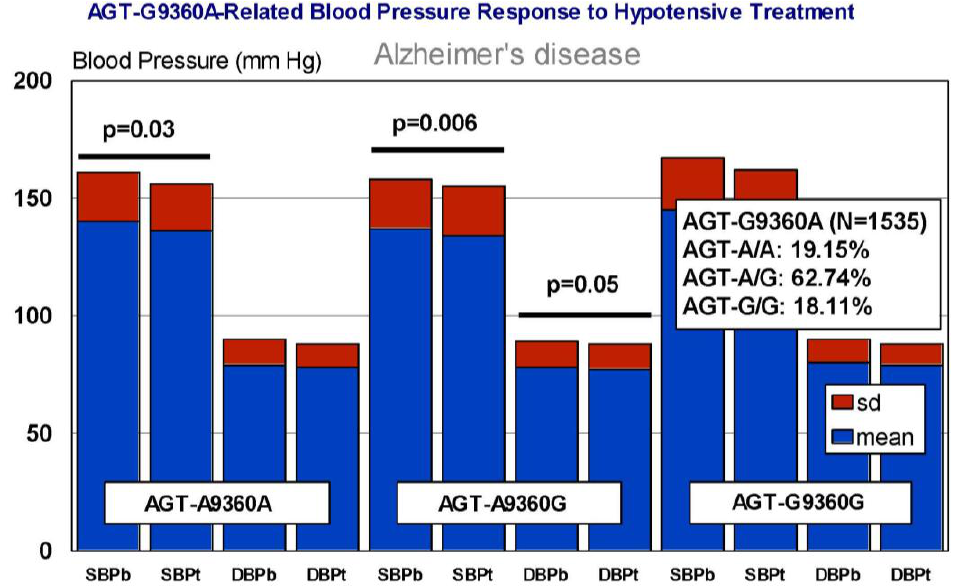
Figure 17. AGT -related blood pressure response to a hypotensive treatment. SBPb: Systolic blood pressure. SBPt: Systolic blood pressure (Enalapril, 10–20 mg/day). DBP: Diastolic blood pressure.